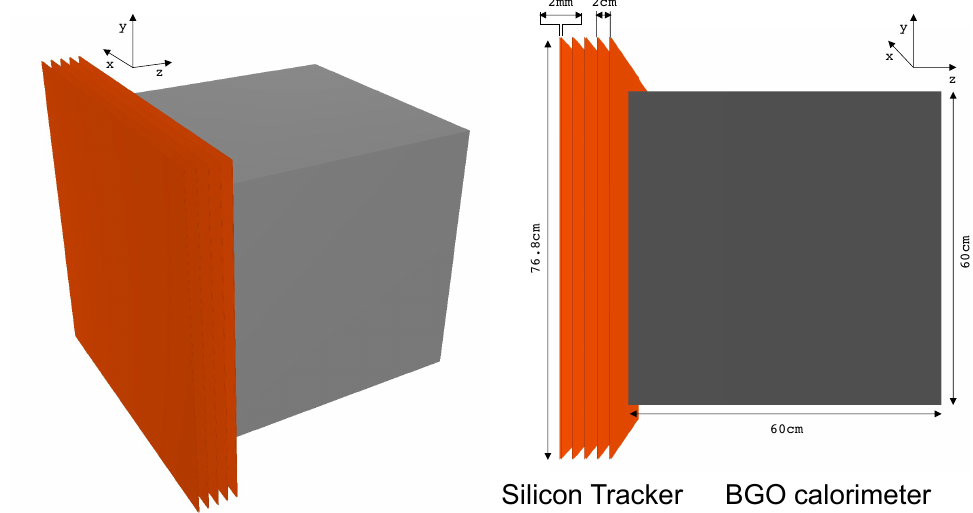
Figure 2. Layout of the simulated detector used in this work to demonstrate and quantify the prospects for timing measurements with Si-microstrip detectors in